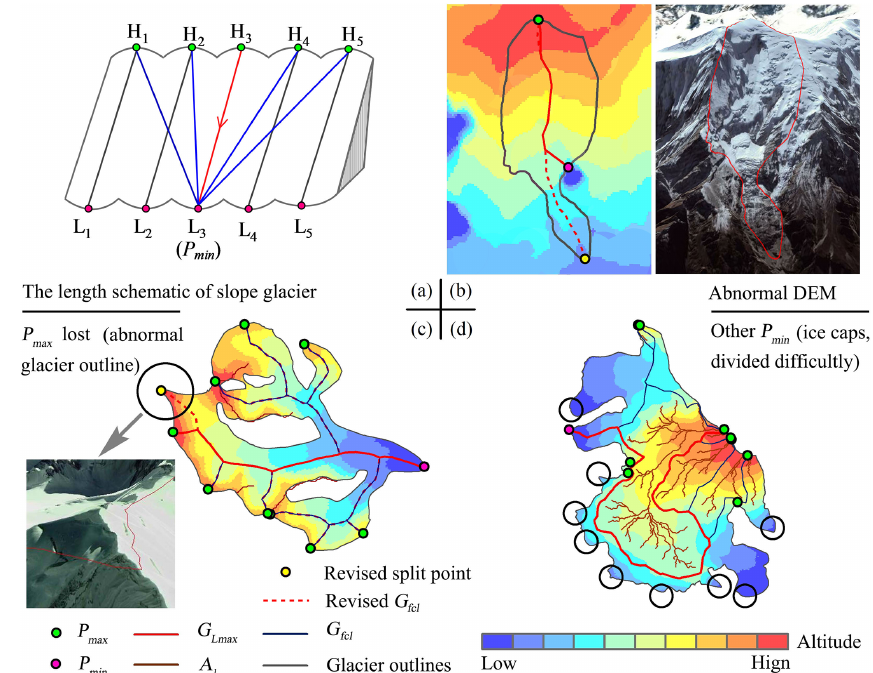
Figure 13. The schematic of probable causes for the abnormal of the longest glacier length. In (b) , the red dashed line indicates the revised glacier centerline, and the yellow point is the correct lowest point ( P min ). In (c) , the red dashed line represents the missing branch, and the yellow point is a local highest point ( P max ) missed by the algorithm. In (d) , the black circle indicates some probable exits of the glacier, which needs to be divided into individual glaciers before extracting the